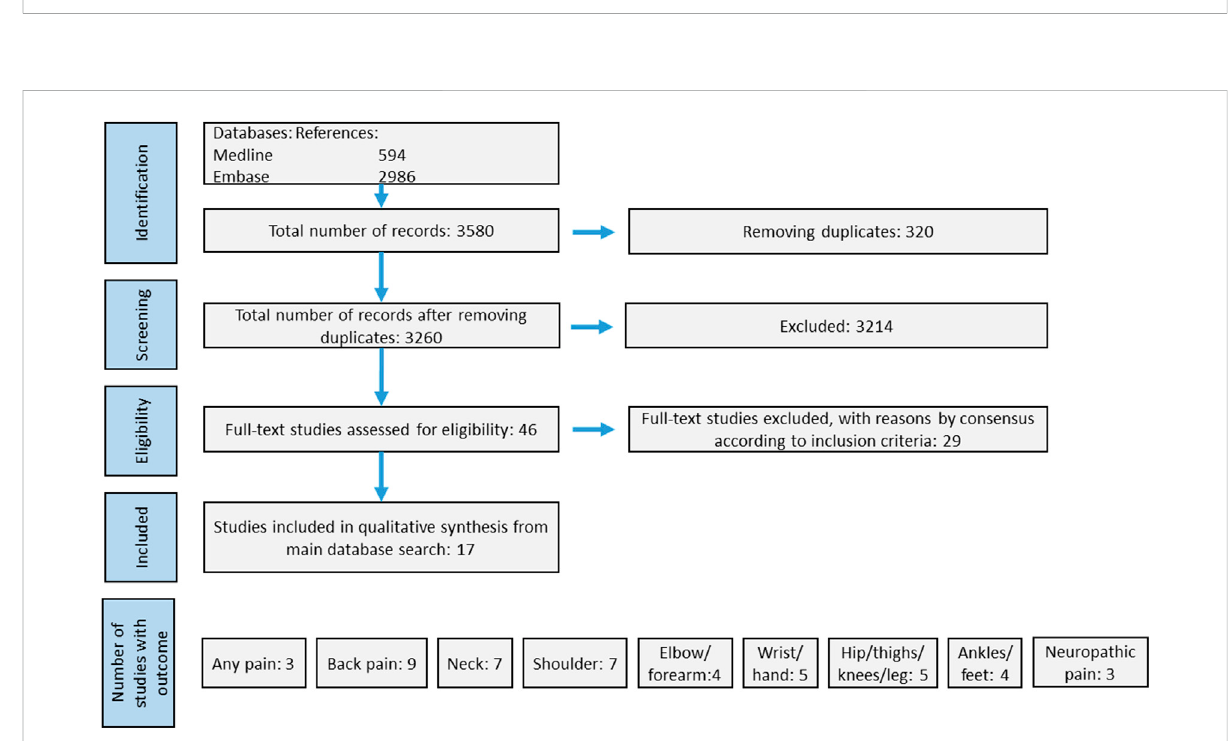
FIGURE 2 Prisma fl ow-chart displaying the literature search history. Of totally 3,580 references, we included 17